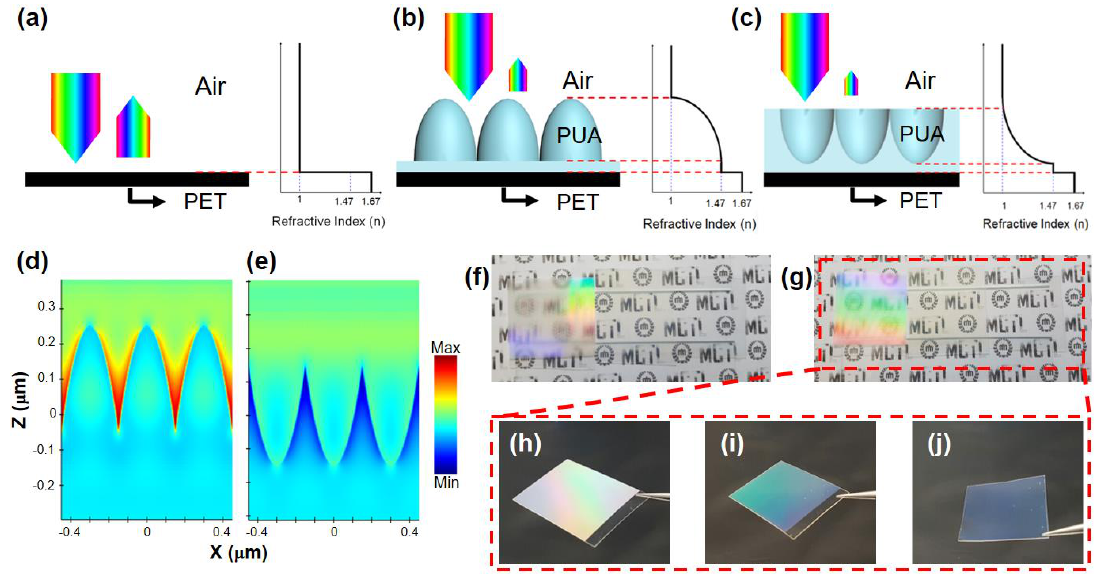
Figure 4. Illustrated refractive index profiles of ( a ) air / PET, ( b ) air / MPS / PET, and ( c ) air / IMPS / PET films. E-field intensity distributions of the ( d ) MPS and ( e ) IMPS at a wavelength of 520 nm. Digital camera images demonstrating structural colors for ( f ) MPS and ( g ) IMPS samples with sizes equal to 300, 500, and 1000 nm, respectively. ( h – j ) Magnified reflected structural colors of the three di ff erent sizes of the IMPS samples.